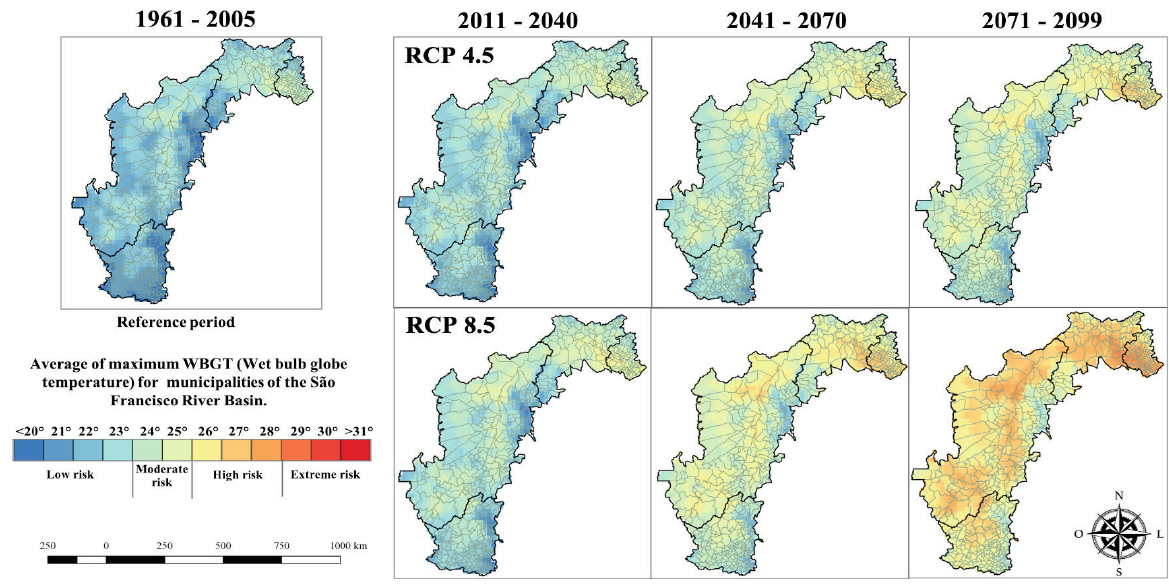
Figure 3 - Projections of the maximum wet bulb globe temperature (WBGt) indicator for the climate scenarios RCP 4.5 and 8.5 for the time windows 2011-2040, 2041-2071 and 2071-2099, comparing to the reference period (1961-2005).